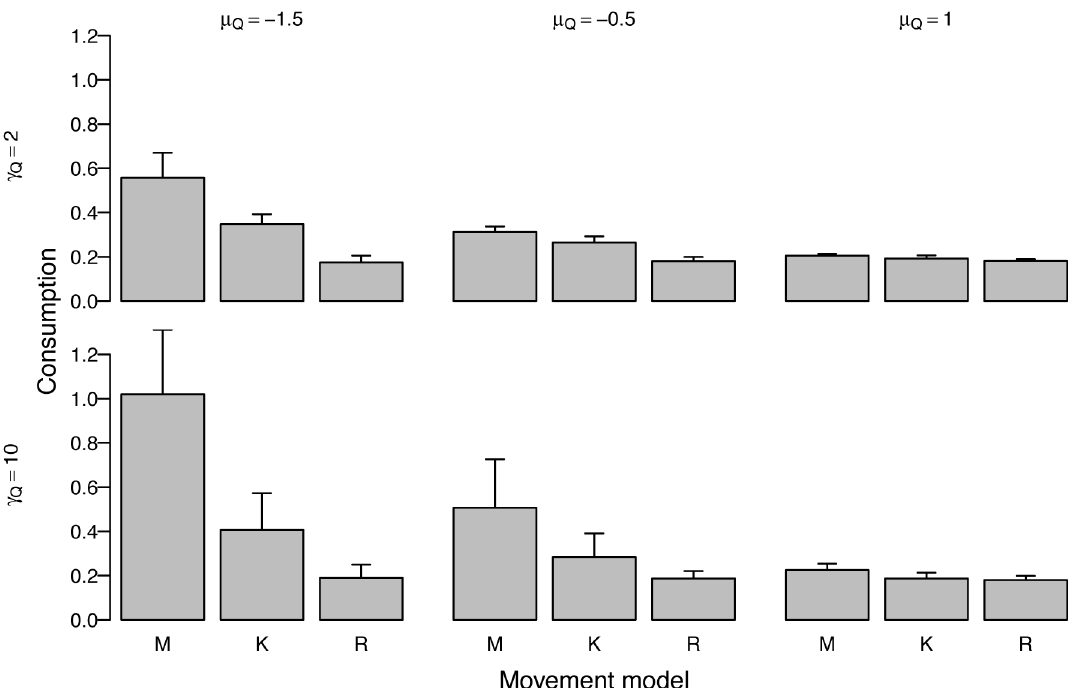
Fig 3. Consumption for the three movement models across different landscape parameters patch concentration μ Q and size γ Q for medium regeneration rate β R = 0.01. Bars show mean consumption values across replicates of landscape parameters while lines show minimum and maximum. Memory is parameterized with best overall parameters, ϕ L = 1 e − 05, ϕ S = 0.01, ψ M = 2, γ Z = 10. In the figure, M = memory, K = kinesis, R = random walk.